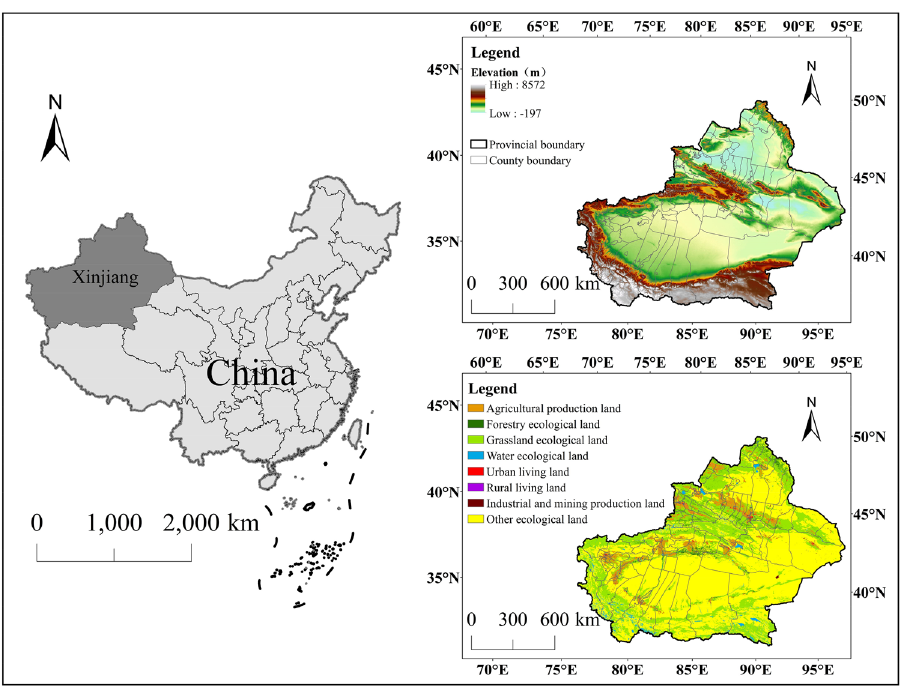
Figure 2. Location of the study area. Map generated with ArcGIS 10.8 (ESRI). URL: https:// suppo rt. esri. com/ en/ Produ cts/ Deskt op/ arcgis- deskt op/